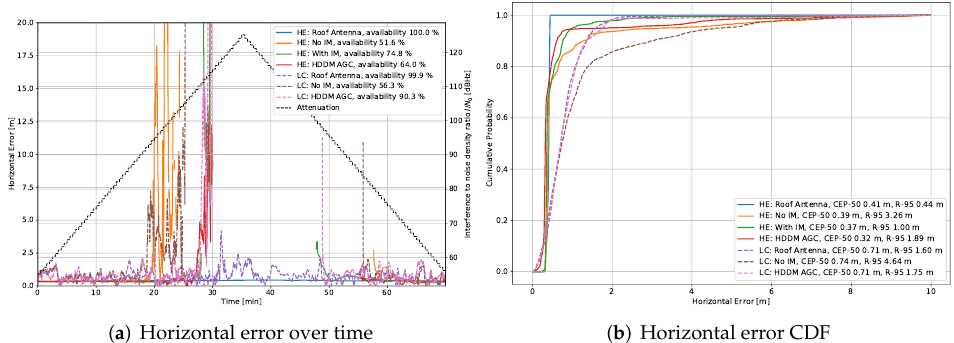
Figure A20. Interference #2: Fast Chirp 10 MHz.